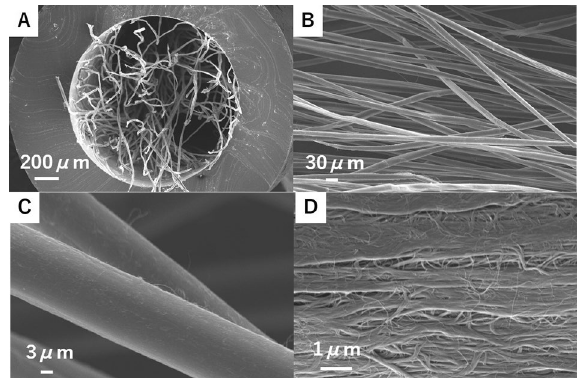
Figure 1. Morphology analysis using scanning electron microscopy of carbon nanotube fibers embedded in a silicon tube. ( A ) The whole cross-sectional structure; with cYarn fibers inside the silicon tube at a 2% density. ( B ) Magnified surface of aligned fibers structures inside the silicon tube. ( C ) External surface of cYarn fibers. ( D ) Magnified external surface of cYarn